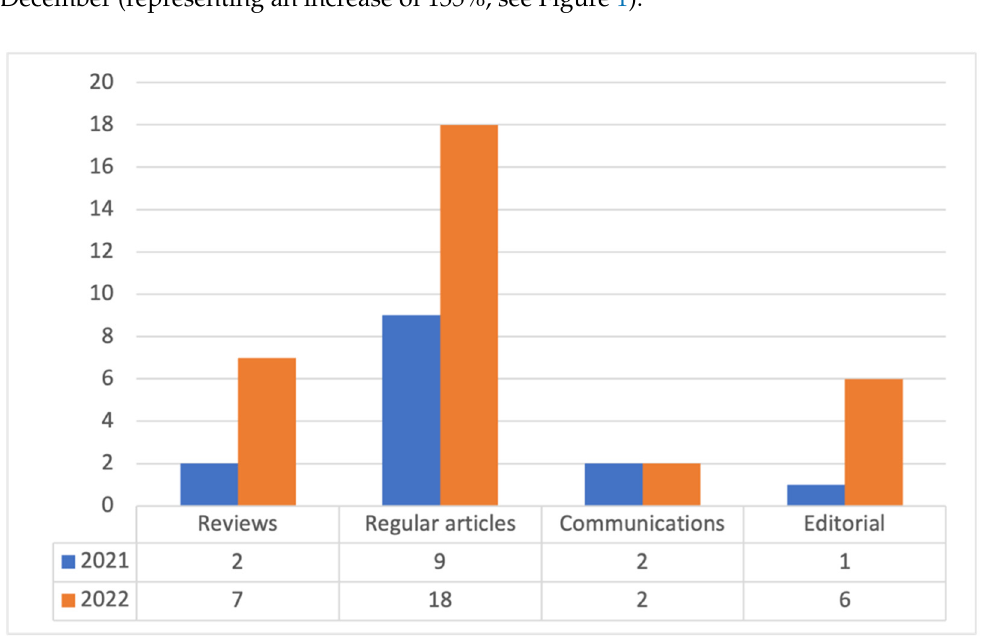
Figure 1. Evolution of publications in Compounds during its first two years.